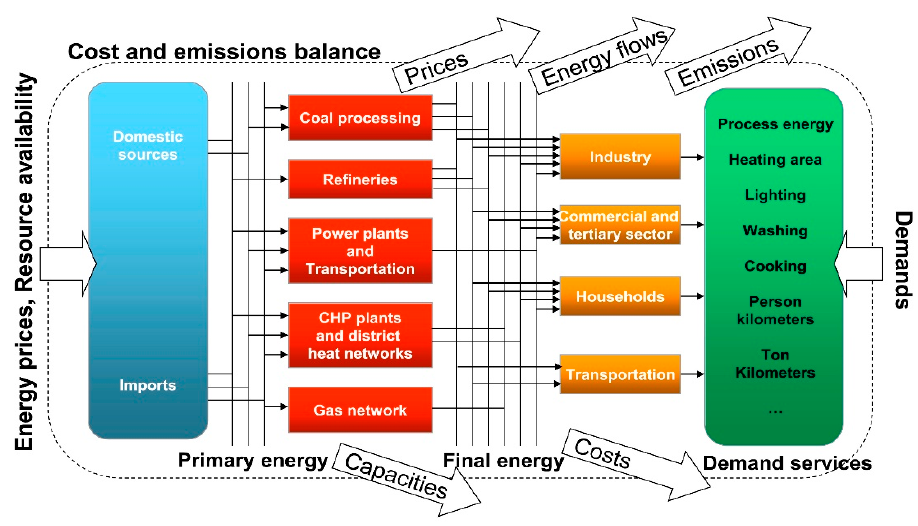
Figure 1. TIMES PanEU reference energy system [28].